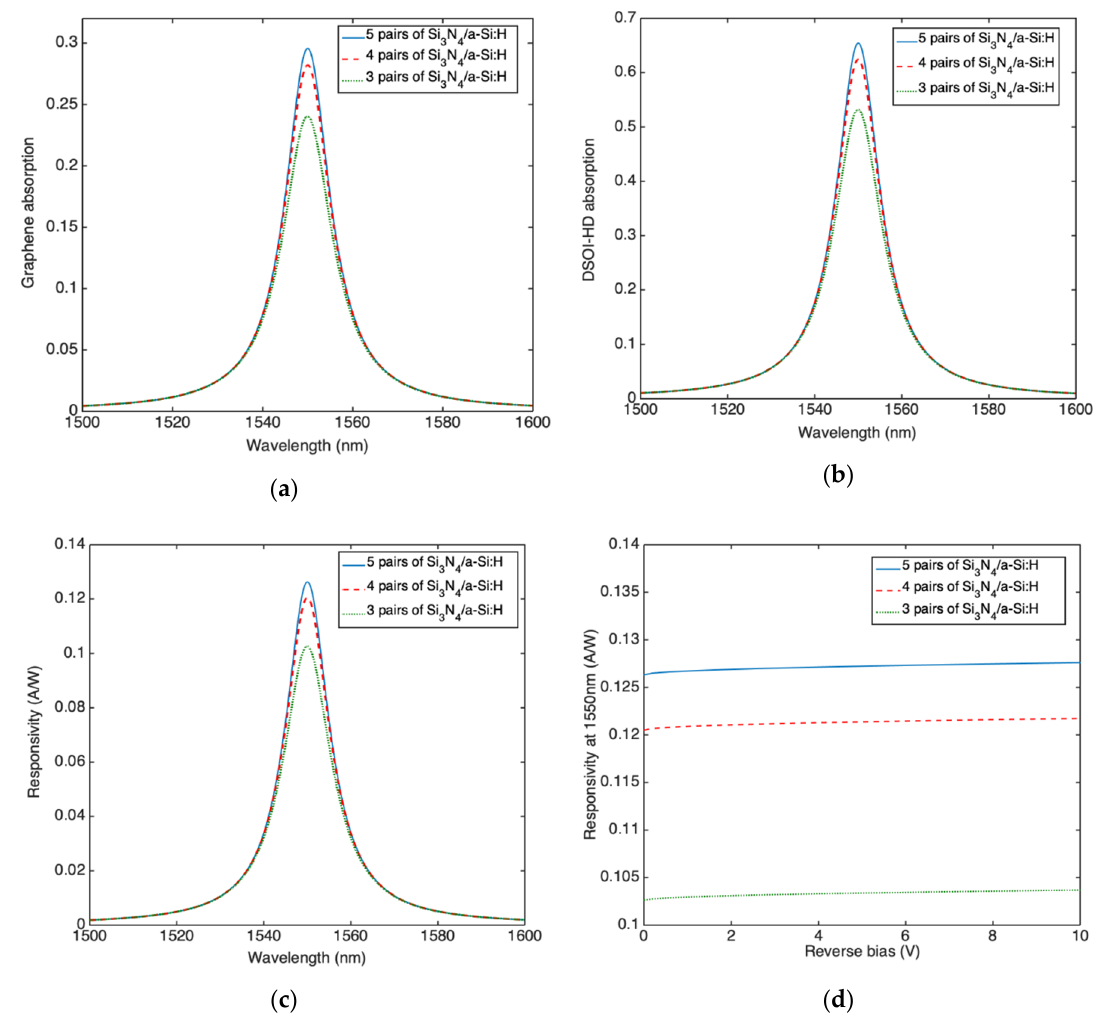
Figure 10. ( a ) Graphene optical absorption, ( b ) DSOI optical absorption, ( c ) responsivity as function of the wavelength for the longitudinal collection configuration (LCC) Fabry–Pérot graphene/Si Schottky PD provided of a DBR output mirror constituted by 3, 4 and 5 pairs of Si 3 N 4 /a-Si:H and ( d ) responsivity at 1550 nm as function of the reverse bias.